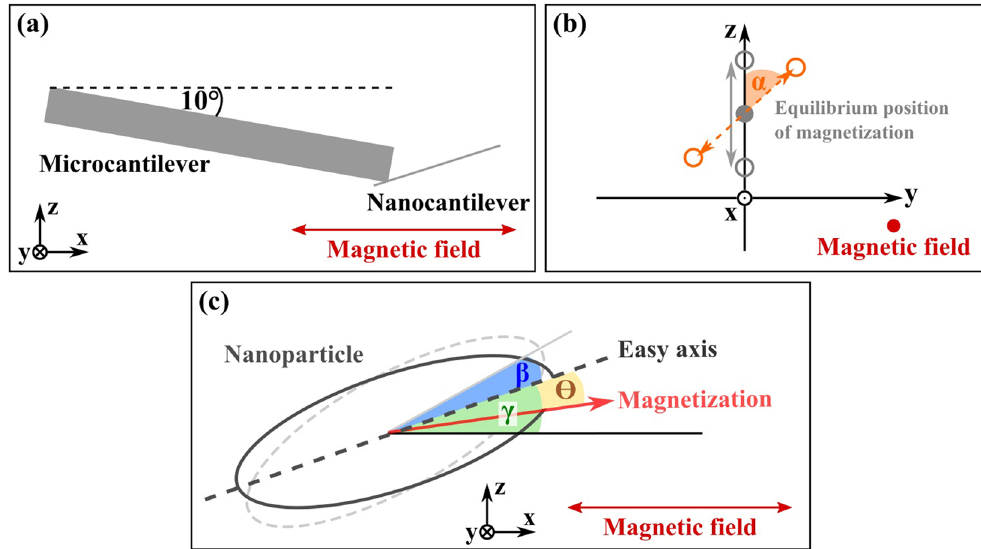
Figure 3. ( a ) Sketch of the sensor setup inside the equipment for the experiment in x-z-plane. ( b ) Magnetization in the y-z-plane. The grey circles indicate an oscillation in the x-z-plane and the orange circles depict the rotation of the oscillation plane by an angle α around the equilibrium position of the magnetization. ( c ) Definition of angles for the nanoparticle on the sensor exposed to a magnetic field. For clarity, the easy axis is defined as the equilibrium position which is tilted by the angle γ with respect to the external magnetic field. The angle β denotes the deflection angle due to sensor and sample oscillation and Θ is the canting of the magnetization away from the easy axis due to oscillation. Angles β and Θ are dependent on each other as discussed above. Please note that the axis of the nanocantilever in ( a ) and the particle easy axis in ( c ) do not necessarily coincide for an actual sample on a